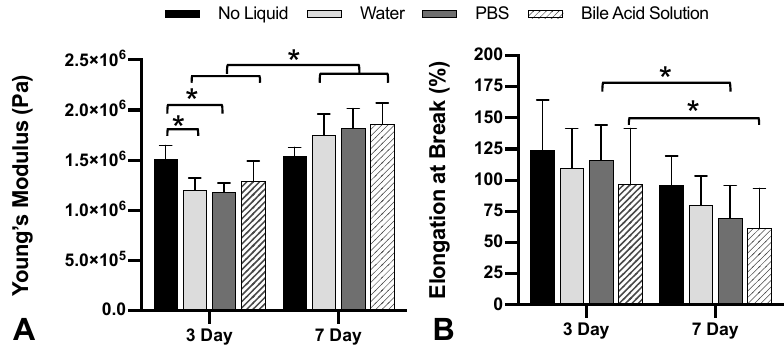
Figure 4. Mechanical properties of Formlabs Elastic polymer after liquid exposure at 37 ◦ C. ( A ) Heat alone did not cause a change in Young’s modulus. Young’s modulus significantly decreases after 3 days exposed to heat and water or PBS (N = 6, * = p < 0.05) and increases after 7 days in all liquids (N = 6, * = p < 0.001). ( B ) Decreases in elongation at break, significant in PBS- and bile acid solution (BAS)-exposed samples (N = 6, * = p < 0.05), reflect a reduction in peak tensile strength. Liquid-exposed sample weights for water, PBS and BAS increased by 0.63% ± 0.06%, 0.56% ± 0.06%, ◦ and 1.65% ± 0.08%, respectively, over 3 days at 37 C. At 3 days exposure, we also found that all samples incubated showed significantly increased percent elongation at break, an indicator of increased tensile strength (Figure 4B; no liquid: 124.1% ± 40.1%, water: 110.1% ± 31.4%, PBS: 116.1% ± 28.3%, BAS: 97.1% ± 44.4%).